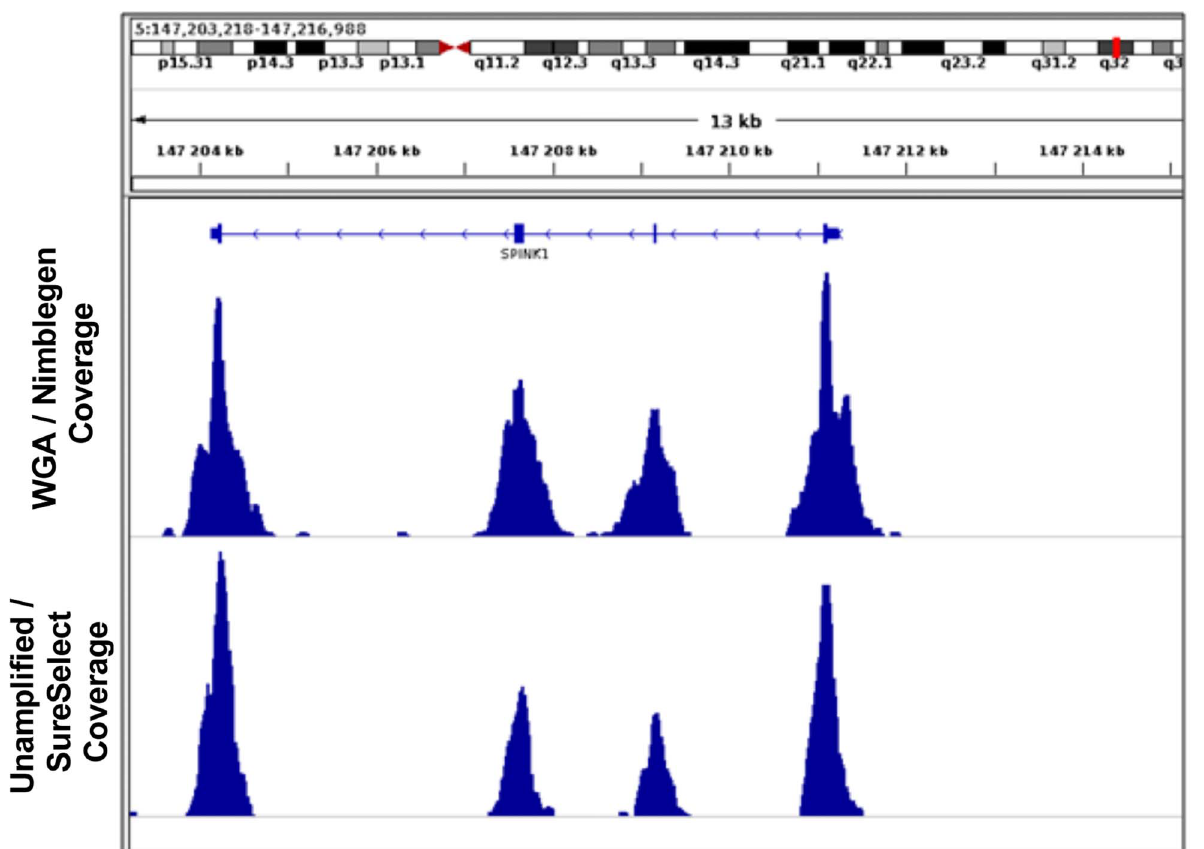
Figure 2. Example of coverage representation in unamplified and whole genome amplified DNA in patient 295 across the SPINK1 gene.